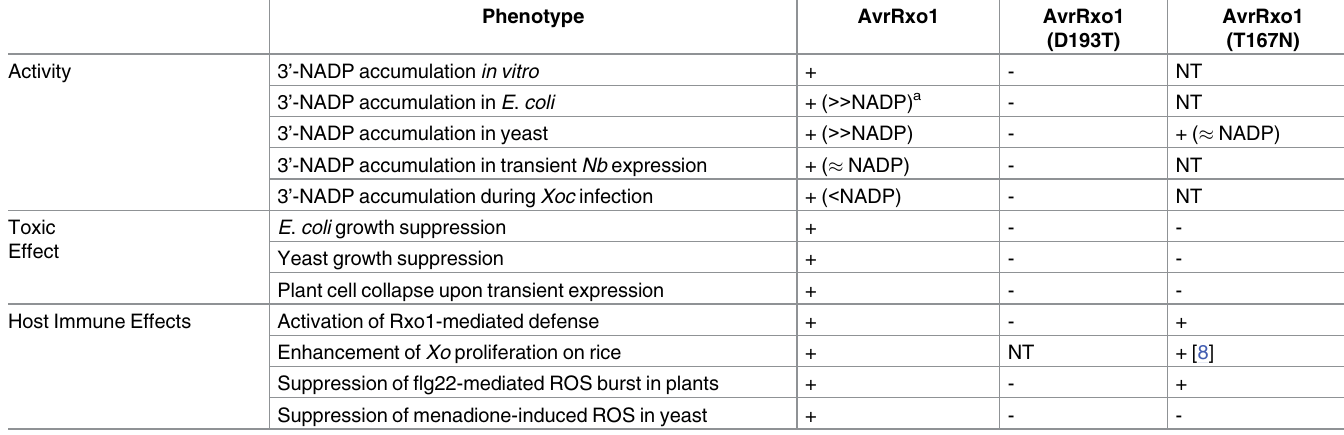
Table 1. Phenotypes of AvrRxo1and catalytic site